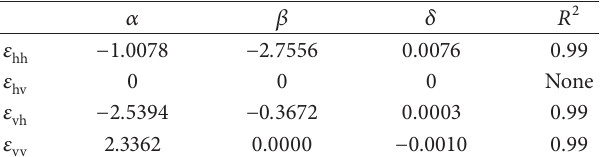
Table 4: The model parameters of a pair of crossed dipoles with the length of 𝜆 in the beam direction (60 ∘ , 45 ∘ ).